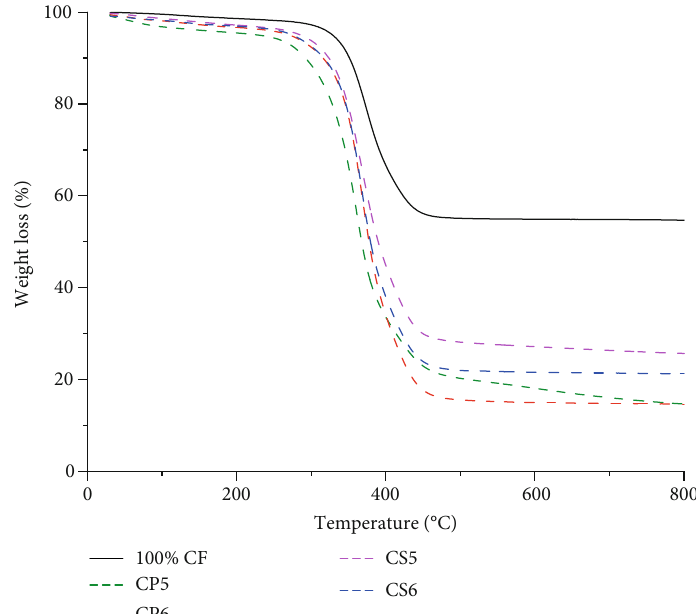
Figure 1: TGA curve on the e ff ect of hybridization of woven kenaf in kenaf/carbon fi bre hybrid woven composite on thermal